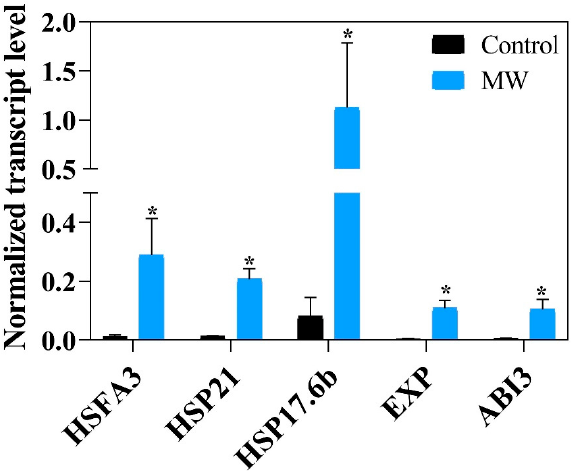
Figure 12. Normalized transcript level at 6 h after imbibition on soybean seeds of the HFA3, HSP21, HSP17.6b, EXP, and ABI3. Each bar represents the means from two samples of 15 embryony axis. The symbol (*) shows a significant difference between the MW and control treatment by t test at a 0.05-confidence level.